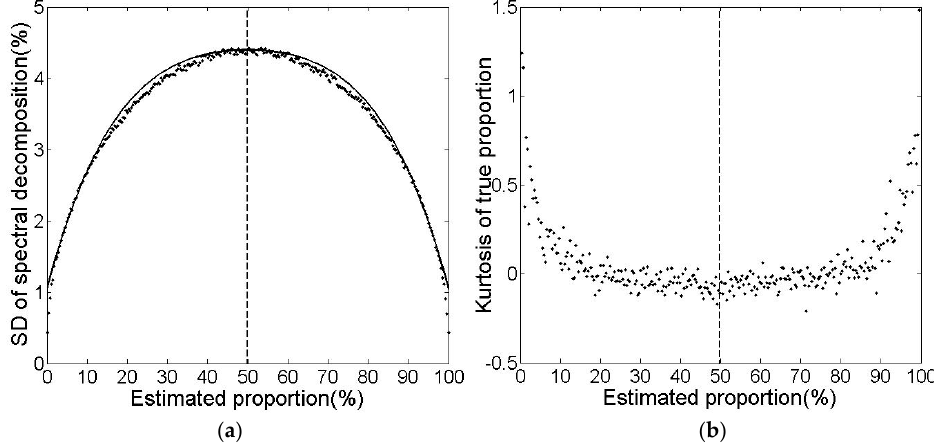
Figure 5. Standard deviation of the spectral unmixing and kurtosis of the true proportion distribution versus the estimated proportion. The solid line in ( a ) is the fitting curve of the standard deviation, and the dashed lines in ( a ) and ( b ) indicate the estimated proportion of 50%.